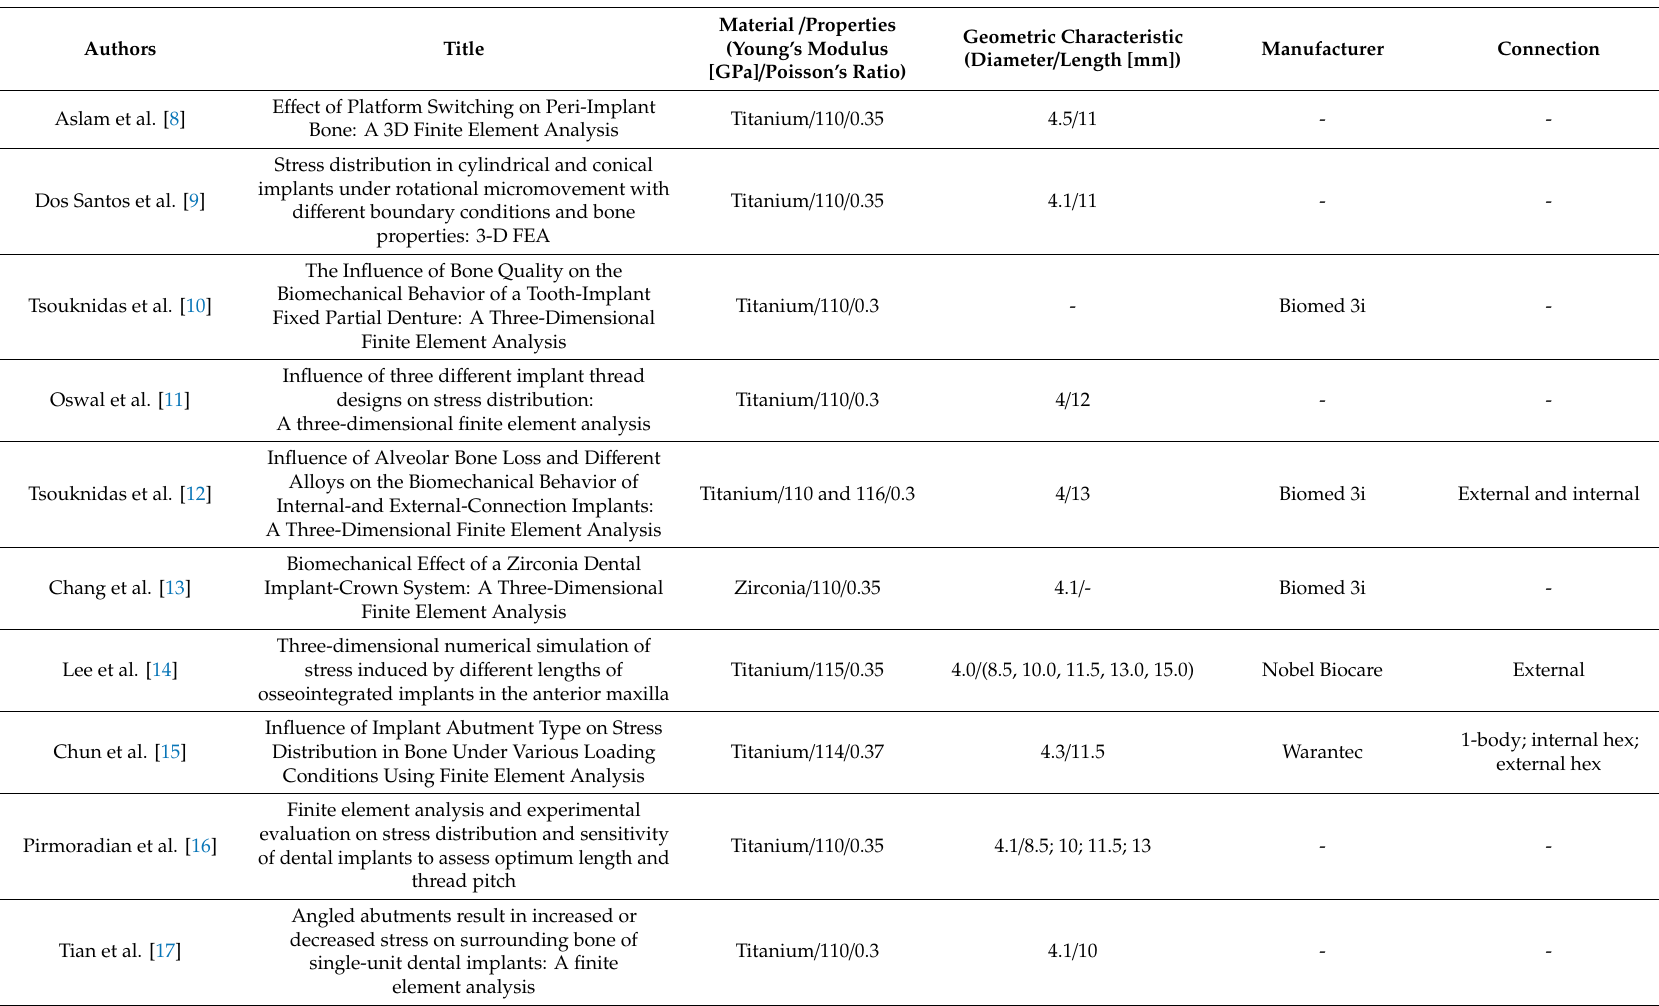
Table 2. Main characteristics of dental